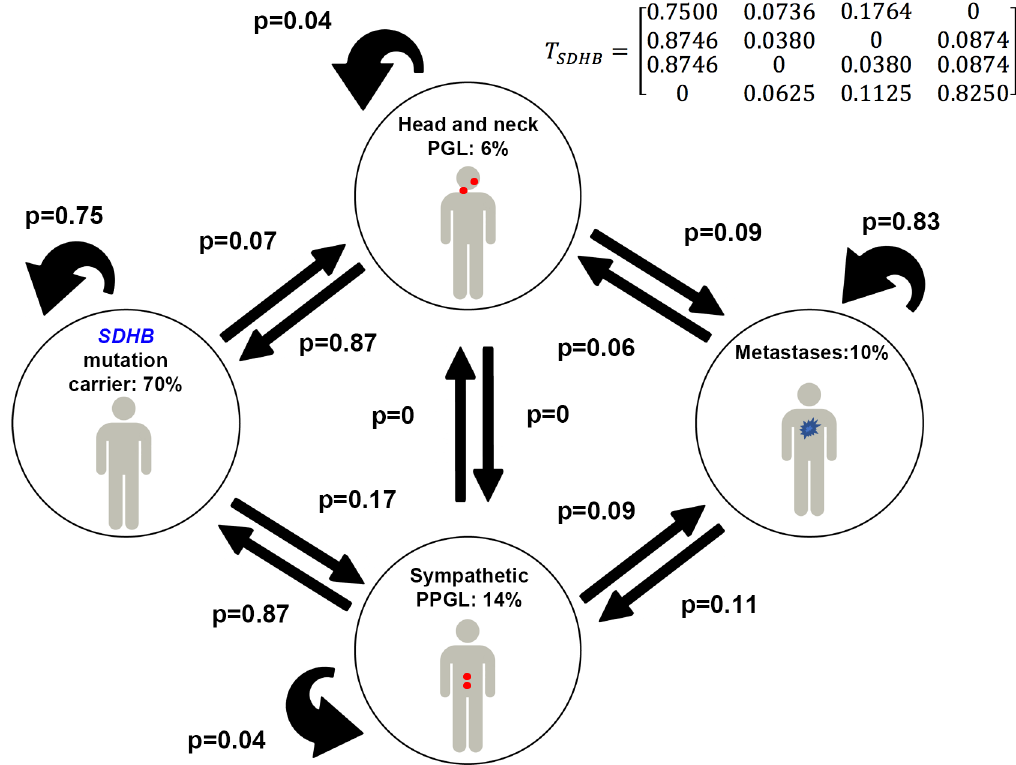
Fig 1. Clinical states and transitions in SDHB -mutation carriers. Transition probabilies are provided in the T sdhb matrix, with 4 rows and 4 columns, upper right. Numerical values for steady states and transition probabilities are displayed here and also given in Table 1 and Table 2. For example, p 12 is the probability of moving from state 1 to state 2 and p 11 is the probability to stay in this state 1.